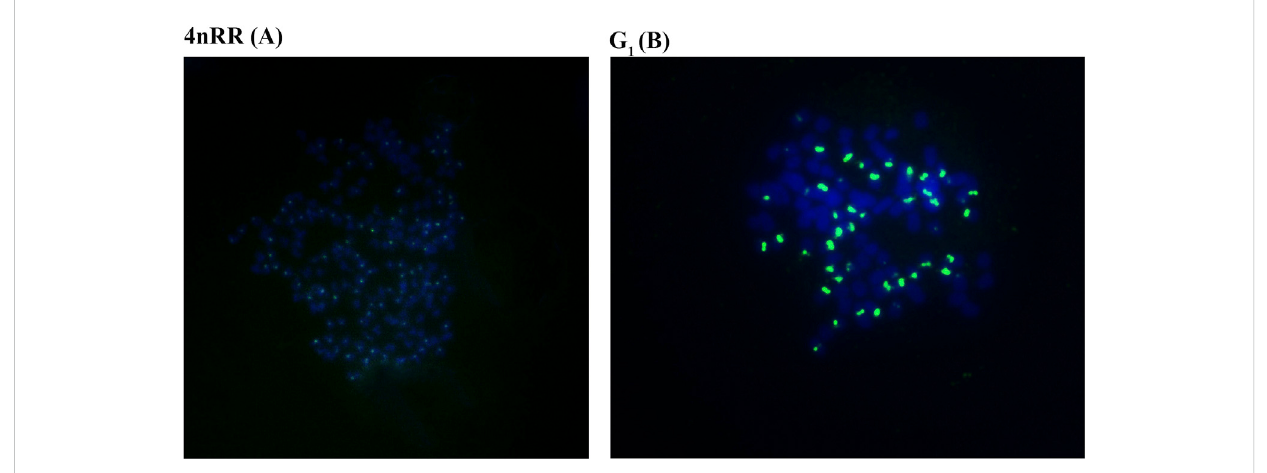
FIGURE 1 Examination of hybridizing signals in the metaphase chromosomes of in 4nRR and G 1 by FISH. The arrows indicate the hybridizing signal loci. One hundred speci fi c centromere repeats loci in the chromosomal metaphases of 4nRR (A) , and fi fty speci fi c centromere repeats loci in the chromosomal metaphases of G 1 (B) . The bars in (A, B) denote 3 μ m.